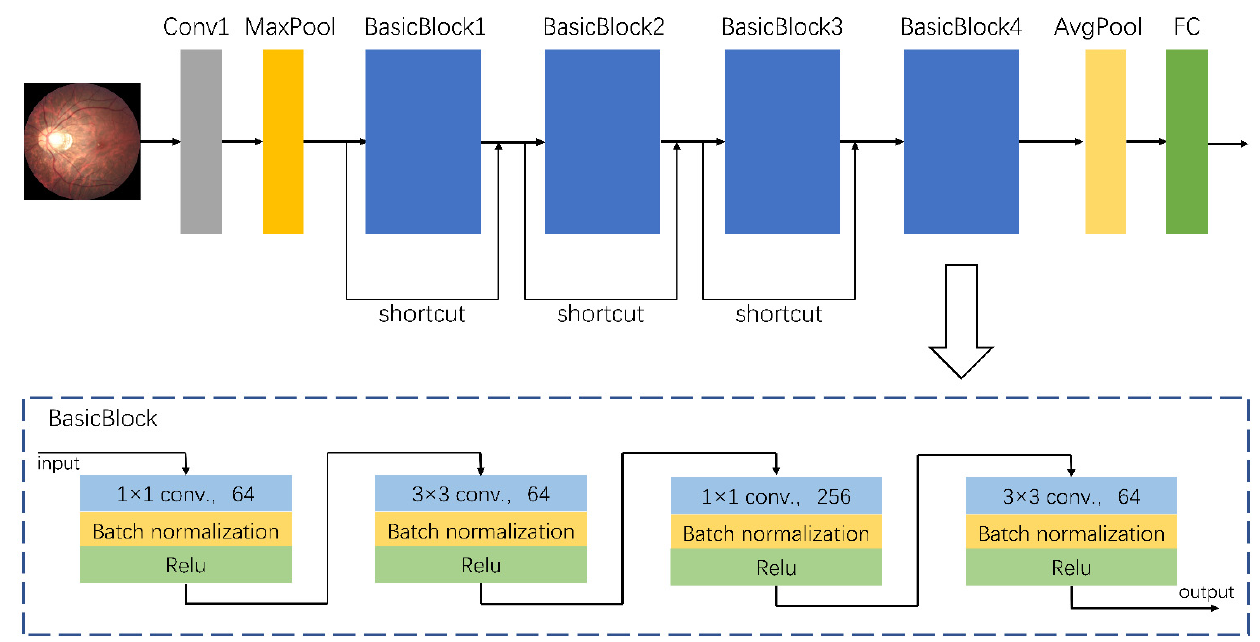
Figure 1. The architecture of the proposed deep convolutional neural networks. The grey block represents the input convolutional layer. The yellow blocks represent the maximum pooling layer or the average pooling layer. The blue blocks are four convolutional basic blocks whose detailed structure is shown at the bottom of the figure. The green block is the final full connected layer used for classification.